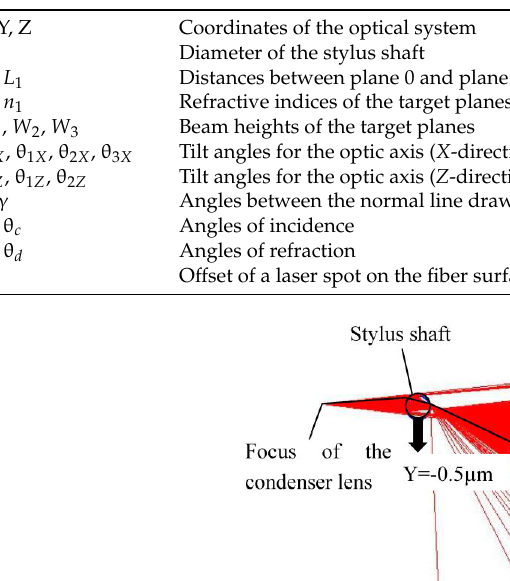
Table 2. Nomenclature used for simulation calculations.